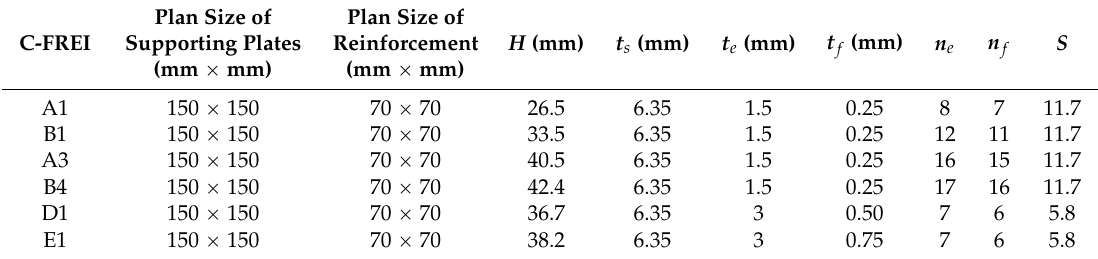
Table 1. Physical and geometric properties of FREIs.